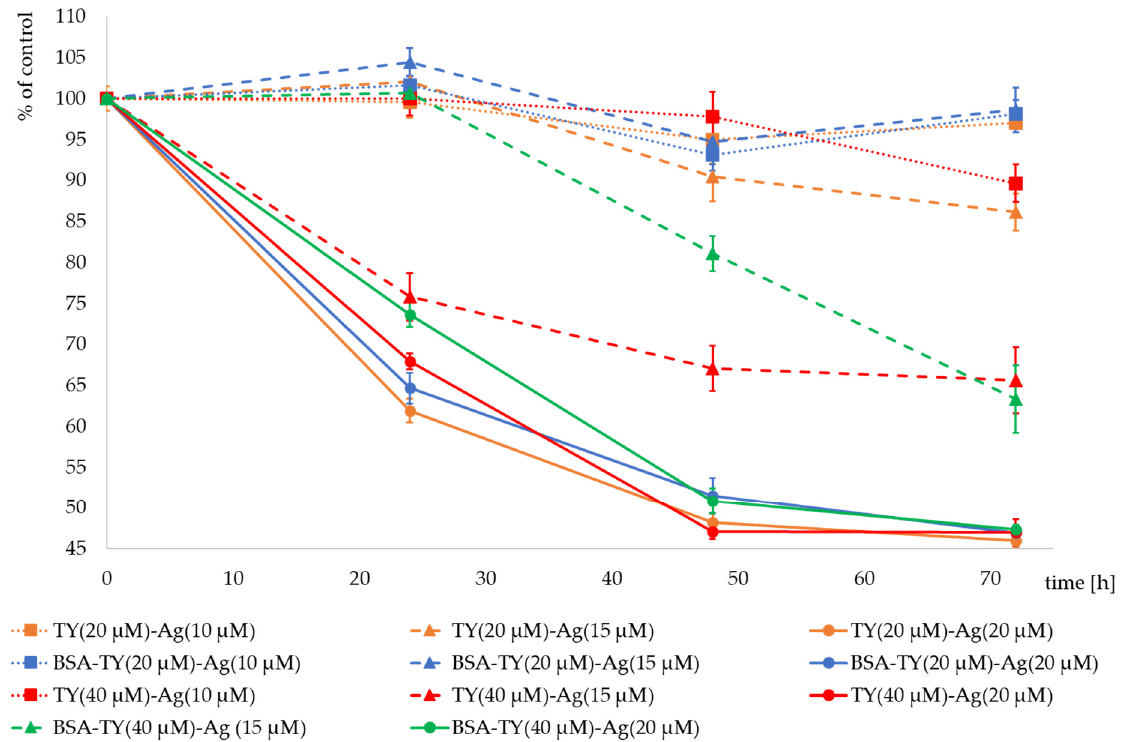
Figure 12. T24 cell proliferation expressed as % of control after addition of Ag + (20 µM) (solid lines) lines) complexed with TY (20 µ M) (yellow), BSA-TY(20 µ M) (blue), TY (40 µ M) (red) and BSA-TY complexed with TY (20 µM) (yellow), BSA-TY(20 µM) (blue), TY (40 µM) (red) and BSA-TY (40 µM) (40 µ M) (green) separately; Ag + (15 µ M) (dashed lines) complexed with TY (20 µ M) (yellow), BSA-TY (green) separately; Ag + (15 µM) (dashed lines) complexed with TY (20 µM) (yellow), BSA-TY (20 (20 µ M) (blue), TY (40 µ M) (red) and BSA-TY (40 µ M) (green) separately; Ag + (10 µ M) (dotted lines) µM) (blue), TY (40 µM) (red) and BSA-TY (40 µM) (green) separately; Ag + (10 µM) (dotted lines) complexed with TY (20 µ M) (yellow), BSA-TY (20 µ M) (blue) and TY (40 µ M) (red) complexed with TY (20 µM) (yellow), BSA-TY (20 µM) (blue) and TY (40 µM) (red) separately.